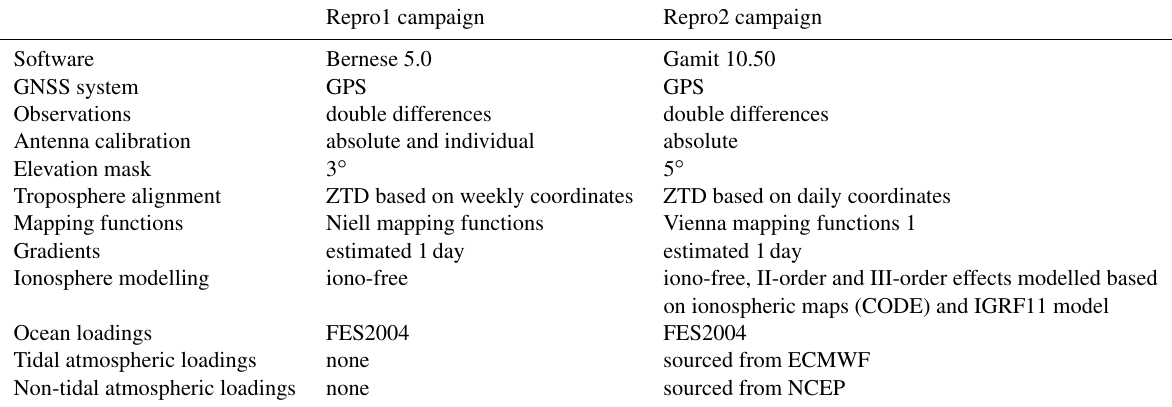
Table 1. Comparison of the processing strategies of the Repro1 and the Repro2